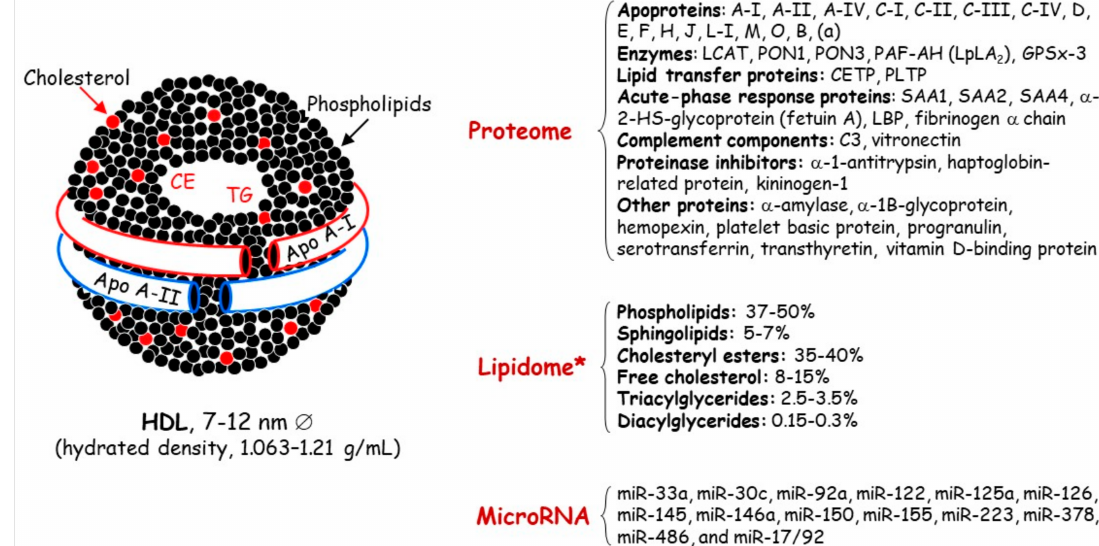
Figure 1. Main lipid and protein components of high-density lipoproteins. Apo, apolipoprotein; CE, cholesteryl esters; C3, complement 3; CETP, cholesteryl ester transfer protein; GSPx-3, glutathione selenoperoxidase 3; HDL, high-density lipoproteins; LCAT, lecithin:cholesterol acyltransferase; LBP, lipid-binding serum glycoproteins; Lp-PLA2, lipoprotein- associated phospholipase A2; MiRNA, microRNA; PAF-AH, platelet-activating factor acetyl hydrolase; PLPT, phospholipid transfer protein; PON, paraoxonase; SAA, serum amyloid A; TG, triglycerides. * HDL content in mol% of total lipids.